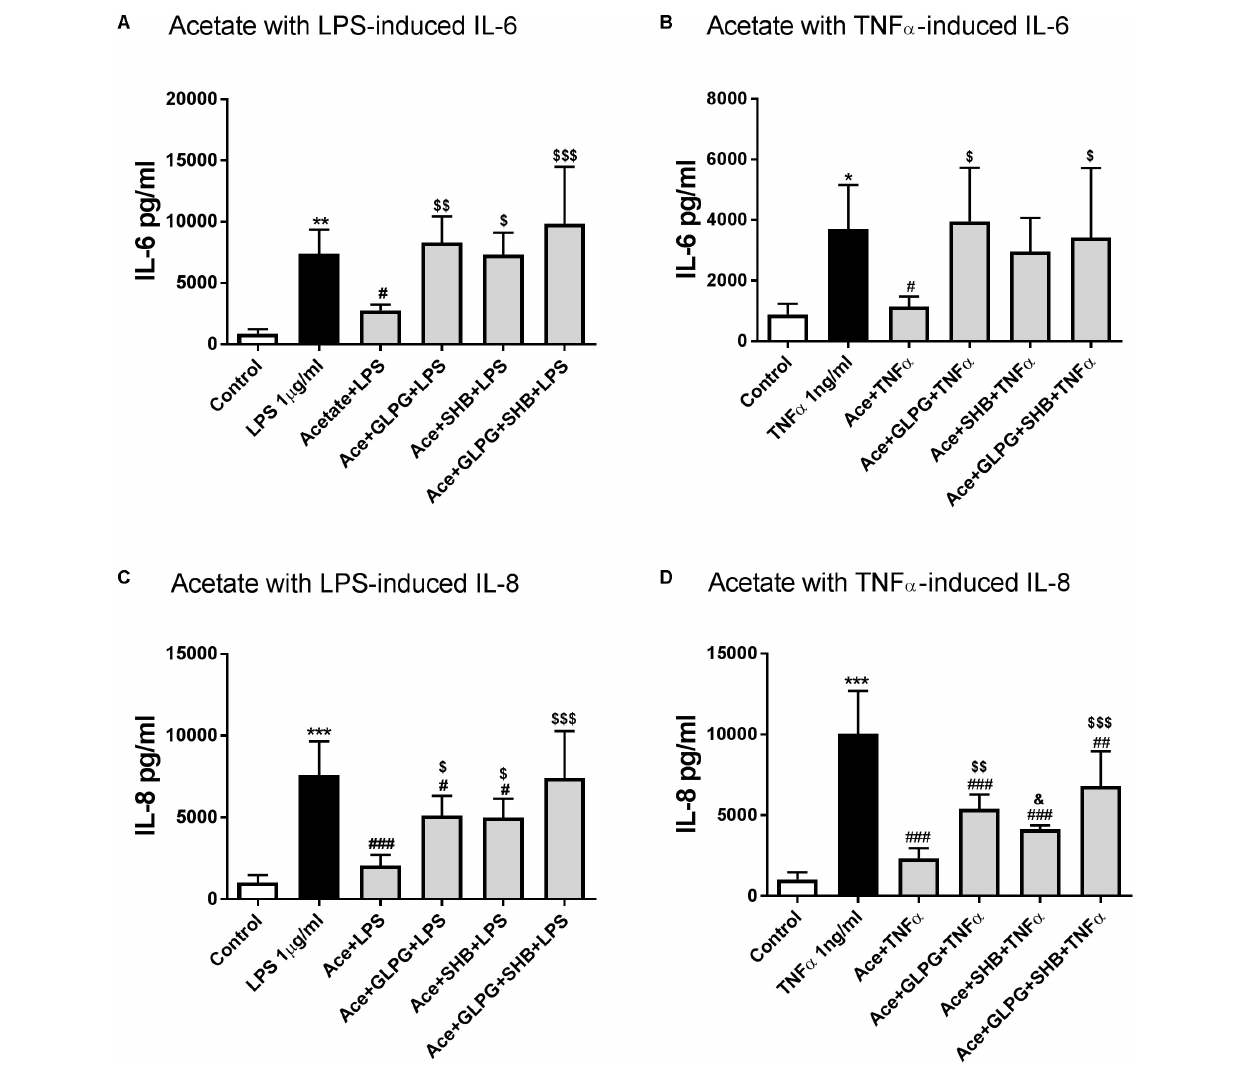
FIGURE 1 | The effects of acetate alone or in combination with GLPG and/or SHB on IL-6 and IL-8 production by LPS- or TNF α -stimulated HUVEC. (A) and (B) show the effects of pre-treatment with acetate alone or combined with GLPG and/or SHB for 16 h on IL-6 production stimulated by LPS or TNF α for 12 h; (C) and (D) show the IL-8 production level after pre-incubating acetate or in combination with GLPG and/or SHB for 16 h and 12 h LPS or TNF α stimulation. N = 4, ∗ p < 0.05, ∗∗ p < 0.01, ∗∗∗ p < 0.001 compared with control group; # p < 0.05, ### p < 0.001 compared with LPS or TNF α group; $ p < 0.05, $$ p < 0.01, $$$ p < 0.001 compared with acetate alone group; & p < 0.05 compared with acetate in combination with GLPG/SHB (AGS) group.